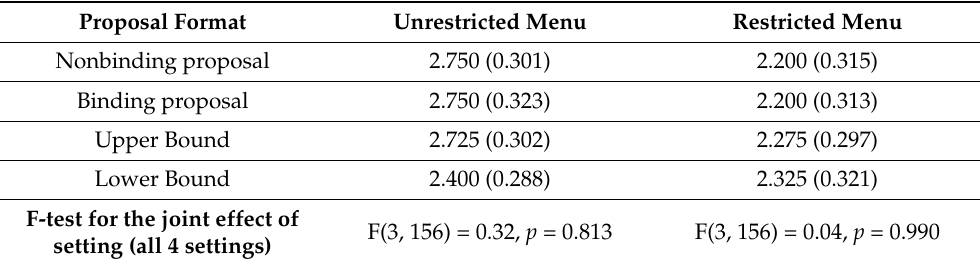
Table 4. Responder’s MAO in each setting (N = 40 per cell, for a total of 320